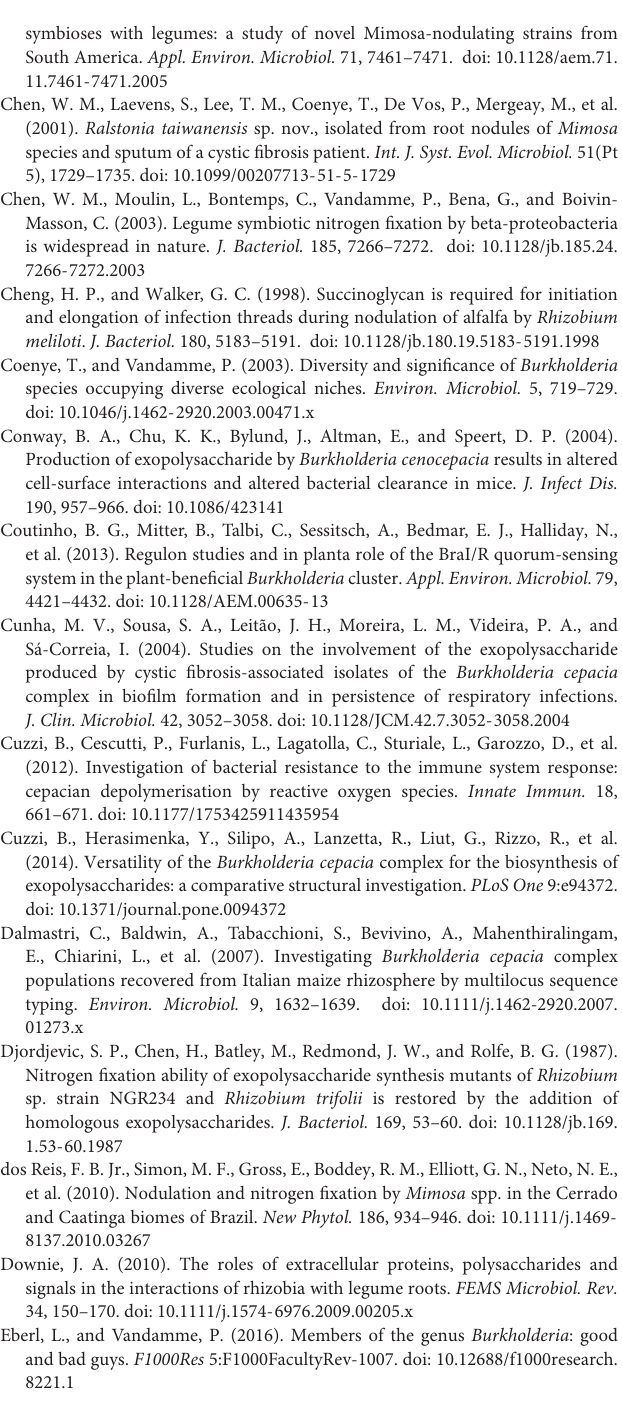
FIGURE S3 | Expression of bceN is induced under nitrogen limiting growth conditions and in presence of root exudates after 24 and 48 h incubation. P. phymatum promoter reporter (WT-pPROBE-bceOVN) cells were incubated in four different minimal media: ABS, AB minimal medium with succinate as carbon source; (A)BS, ABS with limited nitrogen source; ABS + RE, ABS with root exudates; (A)BS + RE, (A)BS with root exudates and under nitrogen limitation. The GFP expression was normalized by cell density OD 600 . Statistical analysis was carried out on (A)BS + RE sample group in comparison with other conditions to